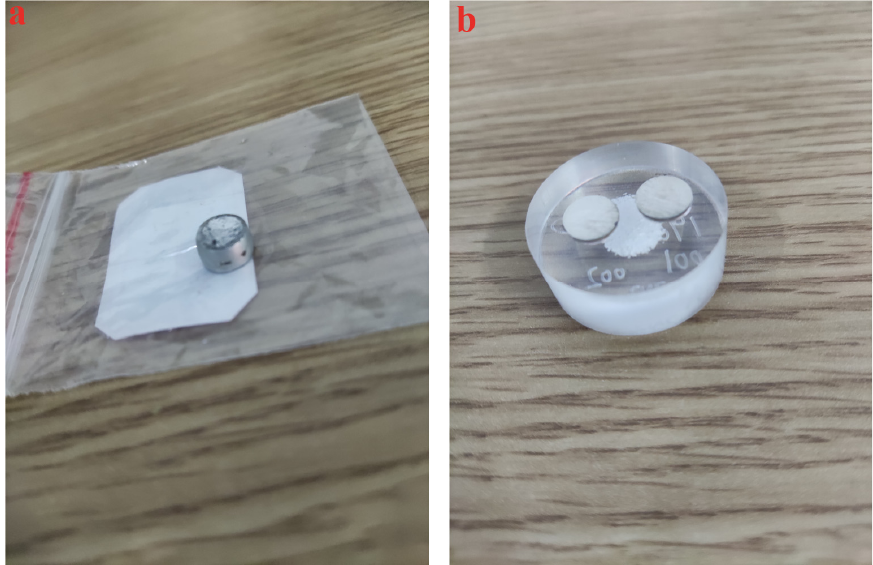
Figure 3. Extruded samples after the Gleeble hot compression experiment. ( a ) Material after hot extrusion deformation; ( b ) The metallographic observation sample.